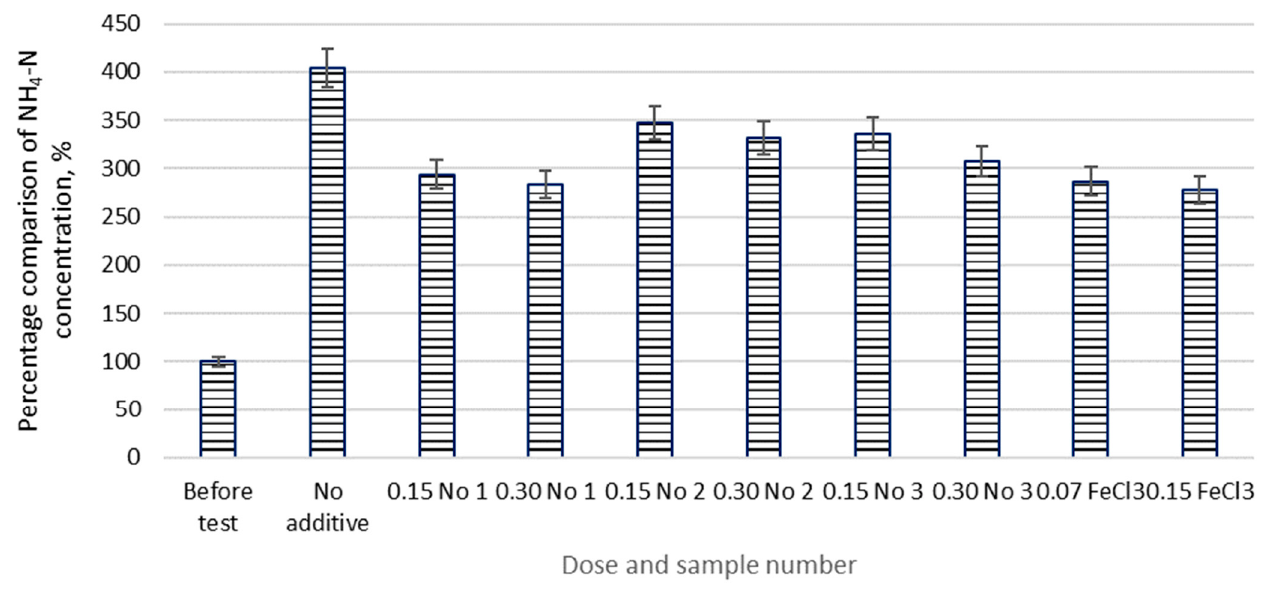
Figure 6. Percentage comparison of ammonium nitrogen concentration in samples. Doses of the additives are indicated in g/g SM/20 d.